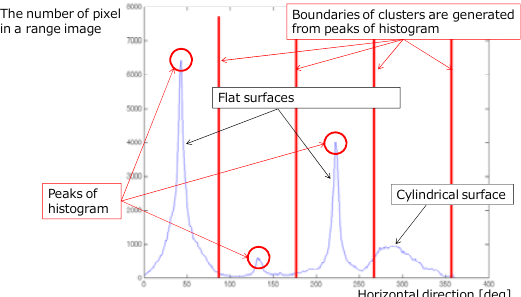
Figure 3. Normal vector clustering; The vertical axis shows the number of pixels in the range image and the horizontal axis shows the horizontal direction. Where flat surfaces exist, there are strong peaks exist in the